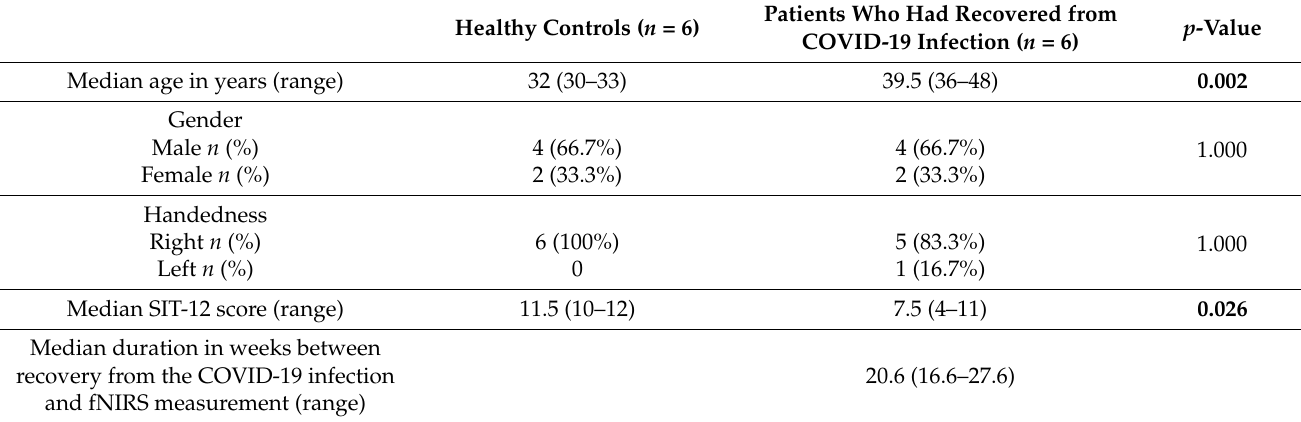
Table 1. Demographic and clinical